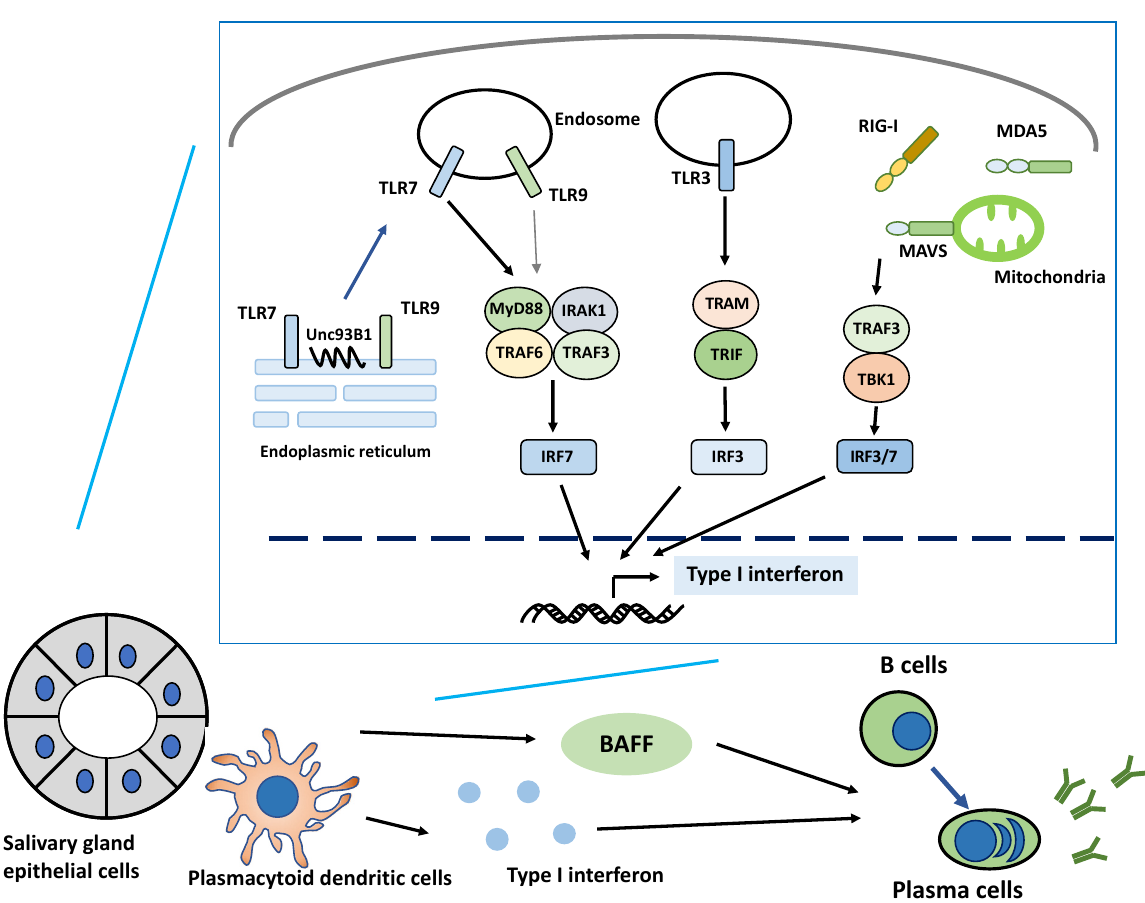
Figure 2. Activation of type I interferon production via endosomal Toll-like receptors and RNA sensor signaling pathway in Sjögren’s syndrome. Endosomal Toll-like receptors (TLRs), RNA sensor retinoic acid-inducible gene I (RIG-I) and melanoma differentiation-associated gene-5 (MDA5) expressed in salivary gland epithelial and infiltrating cells such as plasmacytoid dendritic and B cells in Sjögren’s syndrome induce mainly the production of type I interferon (IFN) via downstream molecules. The balance between TLR7 and TLR9 responses is controlled by Unc93B1, a protein responsible for trafficking TLR7 and TLR9 from the endoplasmic reticulum to the endosome, where TLR7 and TLR9 recognize nucleic acids. Disruption of this control may activate TLR7 signaling and lead to the overproduction of inflammatory cytokines and type I IFN. TLR7 ligand stimulation also enhances the expression of RIG-I and MDA5, synergistically producing a type I IFN signature. The overproduction of type I IFN specifically induces polyclonal B-cell expansion and B-cell differentiation into autoantibody-producing plasma cells. In addition, type I IFN-induced signaling can induce B-cell activating factor (BAFF) production and promote the activation and survival of B cells. The salivary gland epithelial cells in Sjögren’s syndrome are one of the source cells that produce BAFF after the stimulation of type I IFN. Abbreviations: BAFF: B cell-activating factor; IRAK1: interleukin-1 receptor-associated kinase 1; IRF: interferon regulatory factor; MAVS: mitochondrial antiviral signaling protein; MDA5: melanoma differentiation-associated gene-5; MyD88: myeloid differentiation primary response 88; RIG-I: RNA sensors retinoic acid-inducible gene I; TBK: TANK-binding kinase; TLR: Toll-like receptor; TRAF: tumor necrosis factor receptor-associated factor; TRAM: TRIF-related adaptor molecule; TRIF: TIRAP inducing interferon β